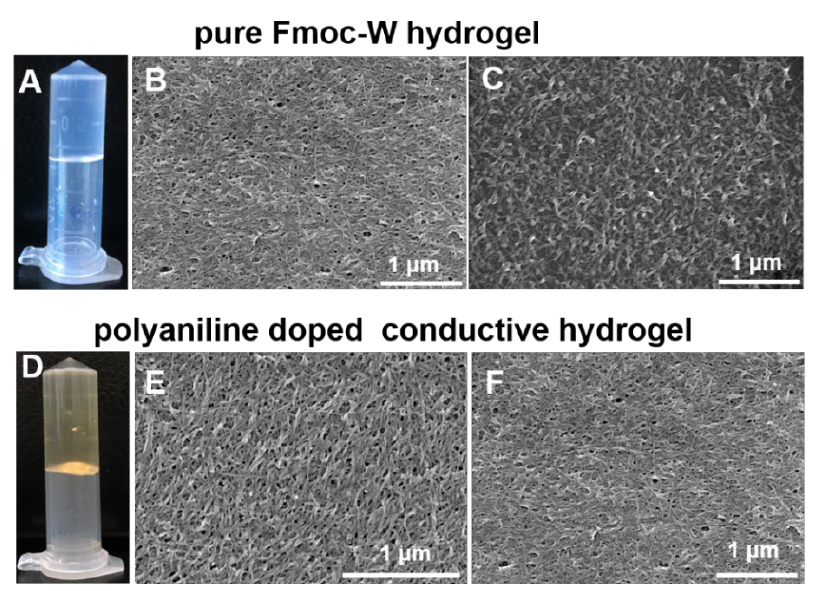
Figure 1. Photo images ( A ) and SEM ( B , C ) characterization of pure Fmoc-W hydrogel; Photo images ( D ) and SEM ( E , F ) characterization of polyaniline doped conductive hydrogel.